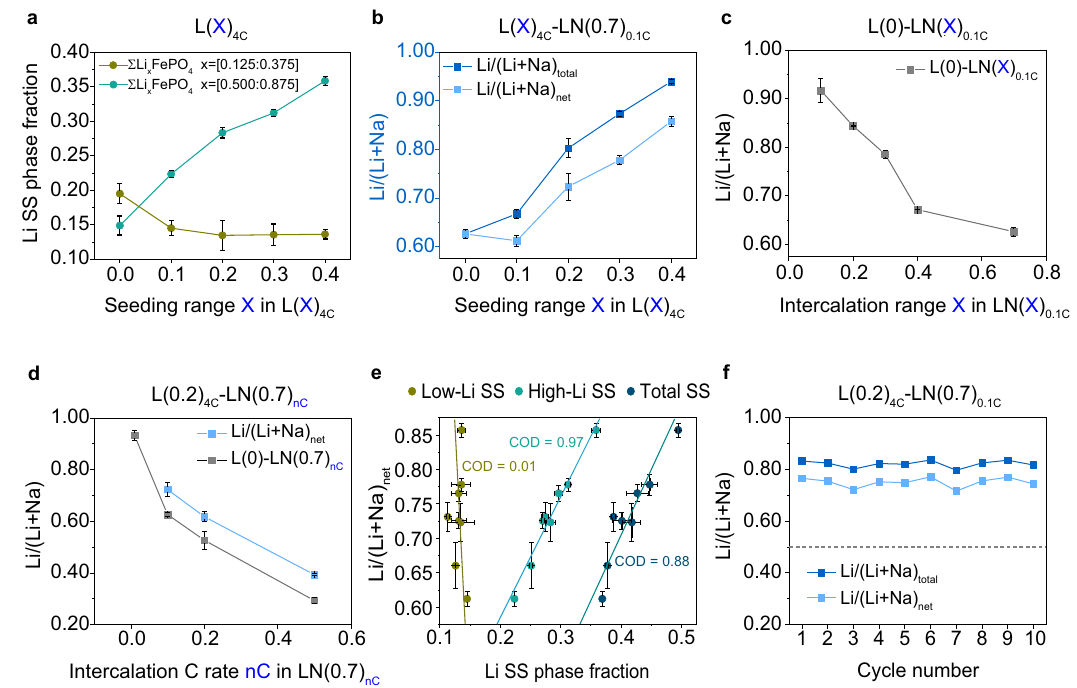
Fig. 3 | Correlation between SS phase fractions and lithium extraction per- formance.a High-LiSS fractions(Li x FePO 4 , x=0.500/0.625/0.750/0.875)and low- Li SS fractions (Li x FePO 4 , x=0.125/0.250/0.375) under the same seeding rate 4C (588mA/g) with different seeding ranges L(0/0.1/0.2/0.3/0.4) 4C . b Li/(Li+Na) total (including the contributions from seeded-Li) and Li/(Li+Na) net (subtracting the contributions from seeded-Li) of the same hosts from a after 0.1C (14.7mA/g) co- intercalation L(X) 4C -LN(0.7) 0.1C . c Li/(Li+Na) ratio of the empty hosts with